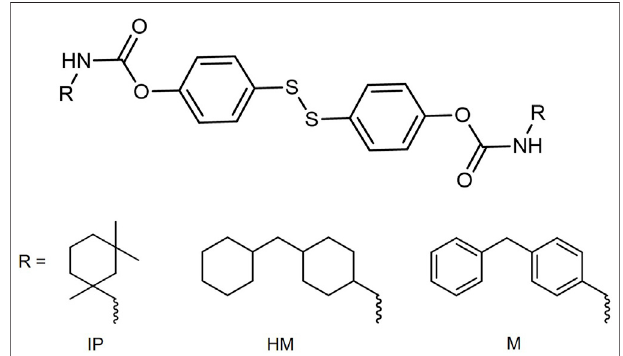
FIGURE1| Hardsegmentsofself-healingPUsincludingdisul fi debonds proposed in Ref. Kim et al. (2017). The nomenclature is related to the isocyanate used togeneratethe hardsegment: IP= isophorone diisocyanate; HM = 4,4 ′ -methylenebis (cyclohexyl isocyanate) and M = 4,4 ′ - methylenebis (phenyl isocyanate).